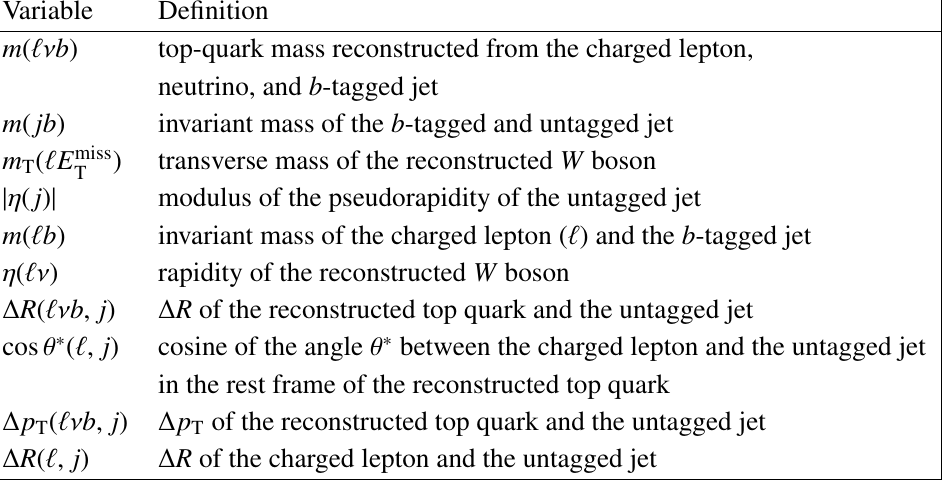
Table 2 . The ten variables that are used in the training of the neural network ordered by their discriminating power as determined by Neurobayes [19,